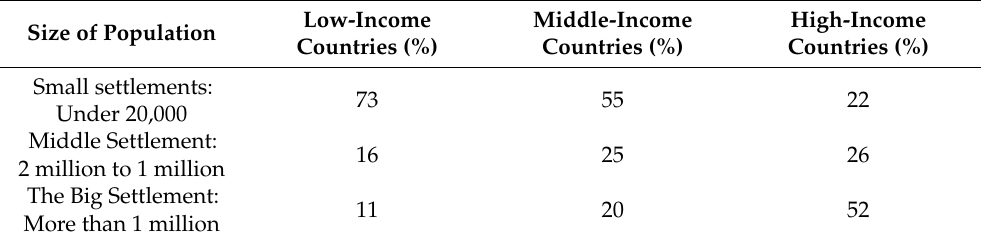
Table 1. The proportion of city size in different development types of countries. Size of Population